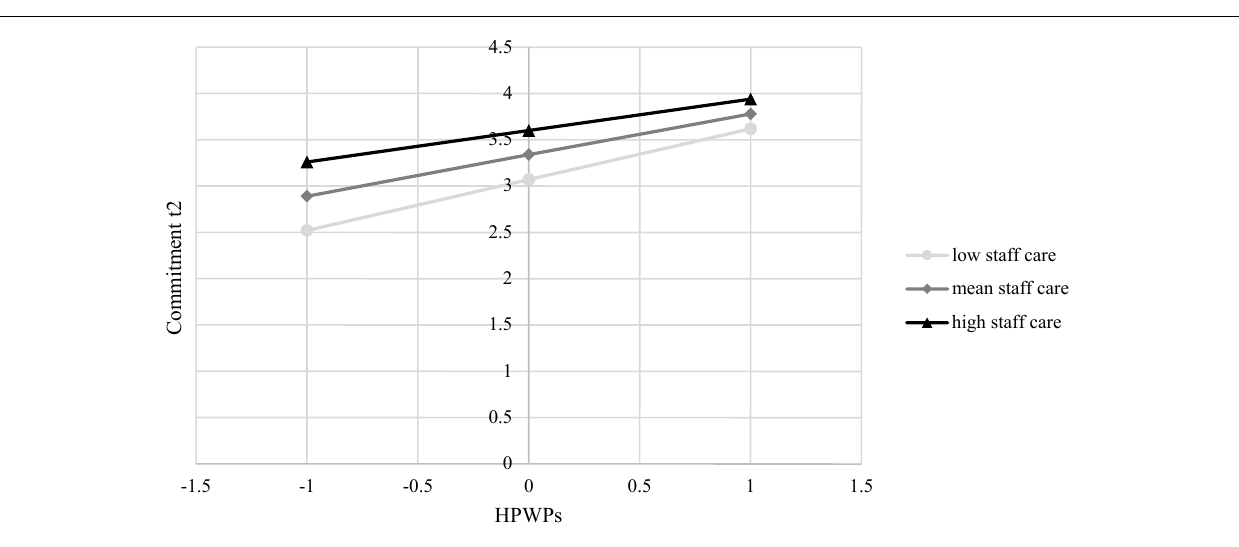
FIGURE 2 | The conditional effect of HPWPs on employees’ commitment at t2 probed at –1SD, mean, and + 1SD for staff